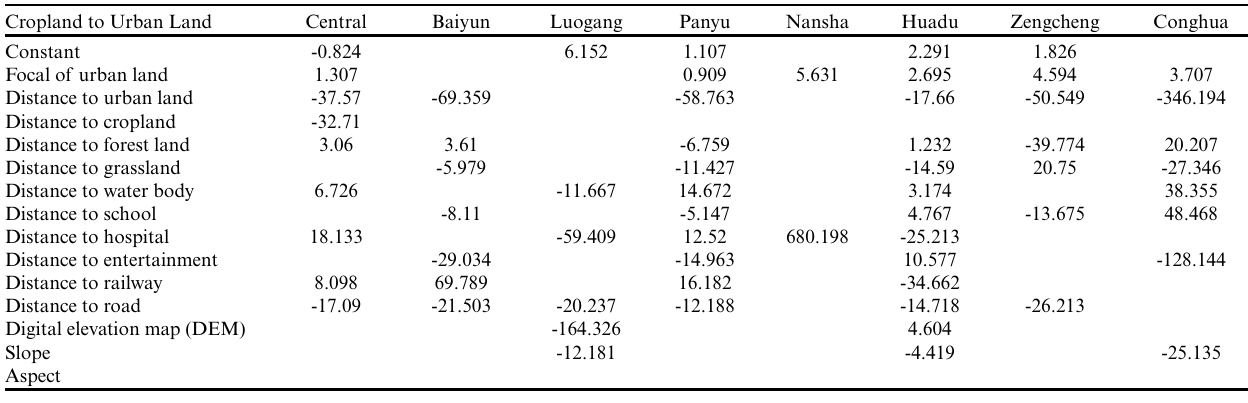
Table 3 . The β values from cropland to urban land in Guangzhou metropolitan area for baseline scenario. Cropland to Urban Land Central Baiyun Luogang Panyu Nansha Huadu Zengcheng Conghua Constant -0.824